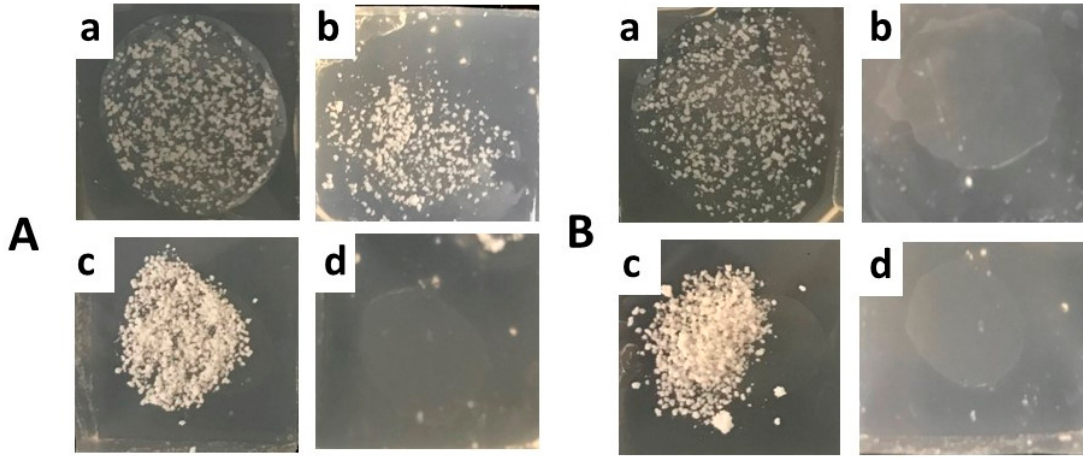
Figure 5. Comparative adhesion test performed on pH 4.5 SVF ( A ) or citrate buffer ( B ) agar plates immersed for 2 h in 10 mL of SVF or citrate buffer, respectively. The images were taken 1 ( a , c ) or 120 ( b , d ) min after the application of Gel LS TRIST/AL1 -CLO ( a , b ) and LS TRIST/AL1 -CLO ( c , d ). Gel acronyms are reported in Table 2.